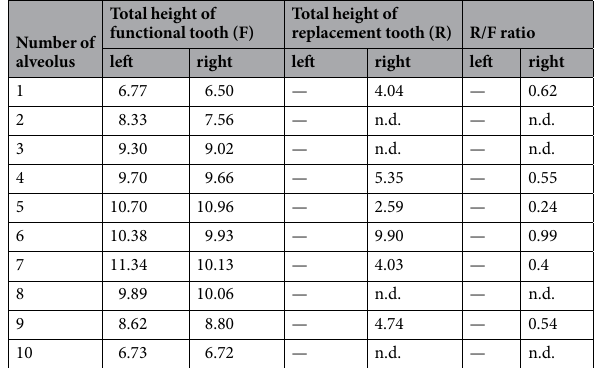
Table 3. Tooth height and the R/F ratio in the upper jaws of IVPP V12633. n.d. = not developed. All measurements in